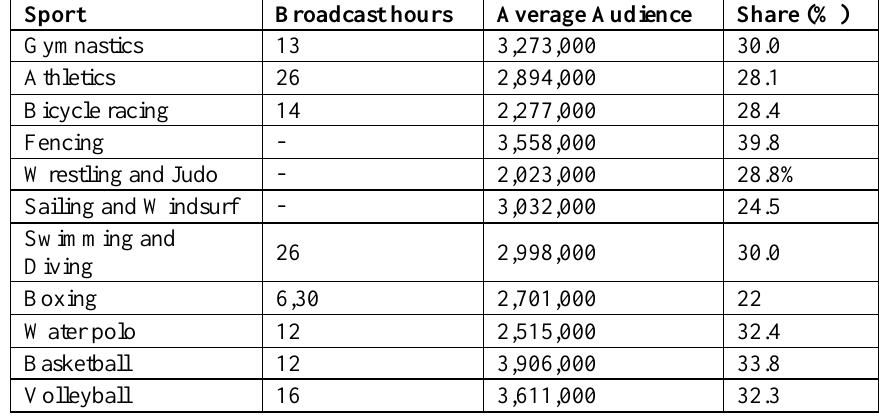
Figure 16: TV Audience in Italy for Major Sports at Athens